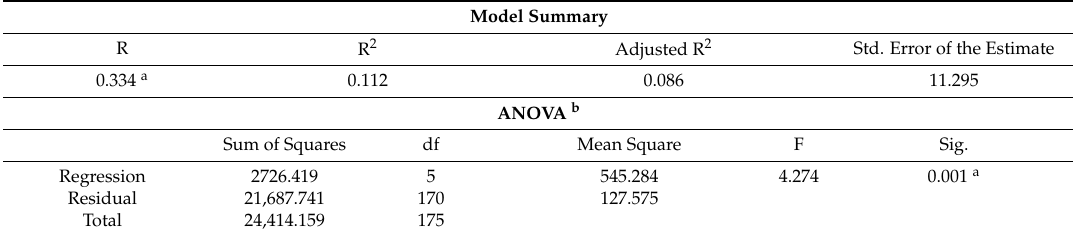
Table 4. Multiple regression model to demonstrate the effect of baseline visual acuity and resolution of morphological features at one year on the degree of change in visual acuity after one year of intravitreal aflibercept